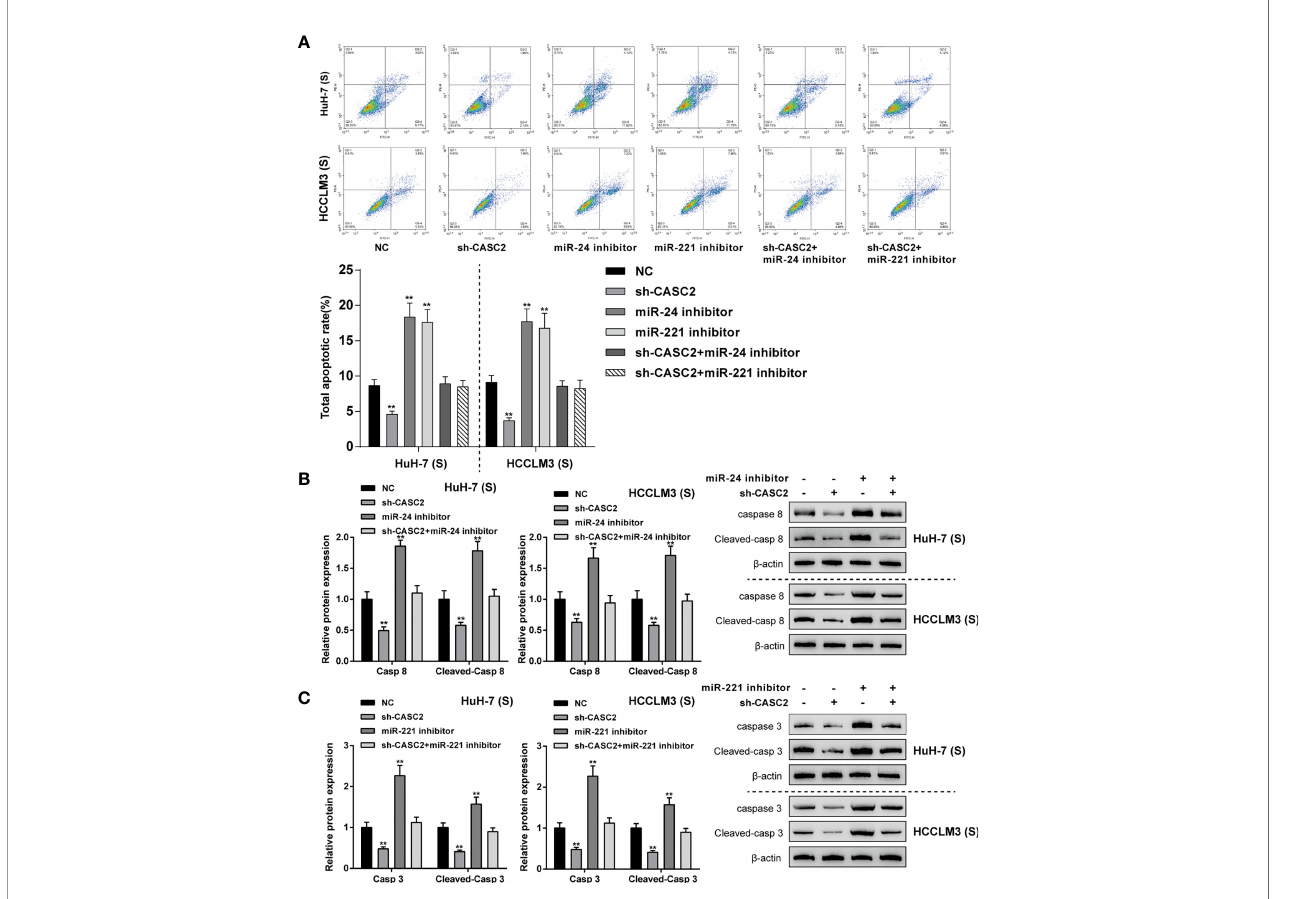
FIGURE 5 | CASC2/miR-24/caspase-8 and CASC2/miR-221/caspase-3 axes modulate apoptosis in Huh-7 (S) and HCCLM3 (S) cells. Huh-7 (S) and HCCLM3 (S) cells were divided into six groups: NC, sh-CASC2, miR-24 inhibitor, miR-221 inhibitor, sh-CASC2+miR-24 inhibitor, and sh-CASC2+miR-221 inhibitor; Huh-7 (S) and HCCLM3 (S) cells were transfected accordingly and examined for cell apoptosis using Flow cytometry (A) ; the protein levels of caspase-8 and cleaved-caspase-8 in NC, sh-CASC2, miR-24 inhibitor, and sh-CASC2+miR-24 inhibitor groups using Immunoblotting (B) ; the protein levels of caspase-3 and cleaved-caspase-3 in NC, sh-CASC2, miR-221 inhibitor, and sh-CASC2+miR-221 inhibitor groups using Immunoblotting (C) . **p < 0.01 compared with NC